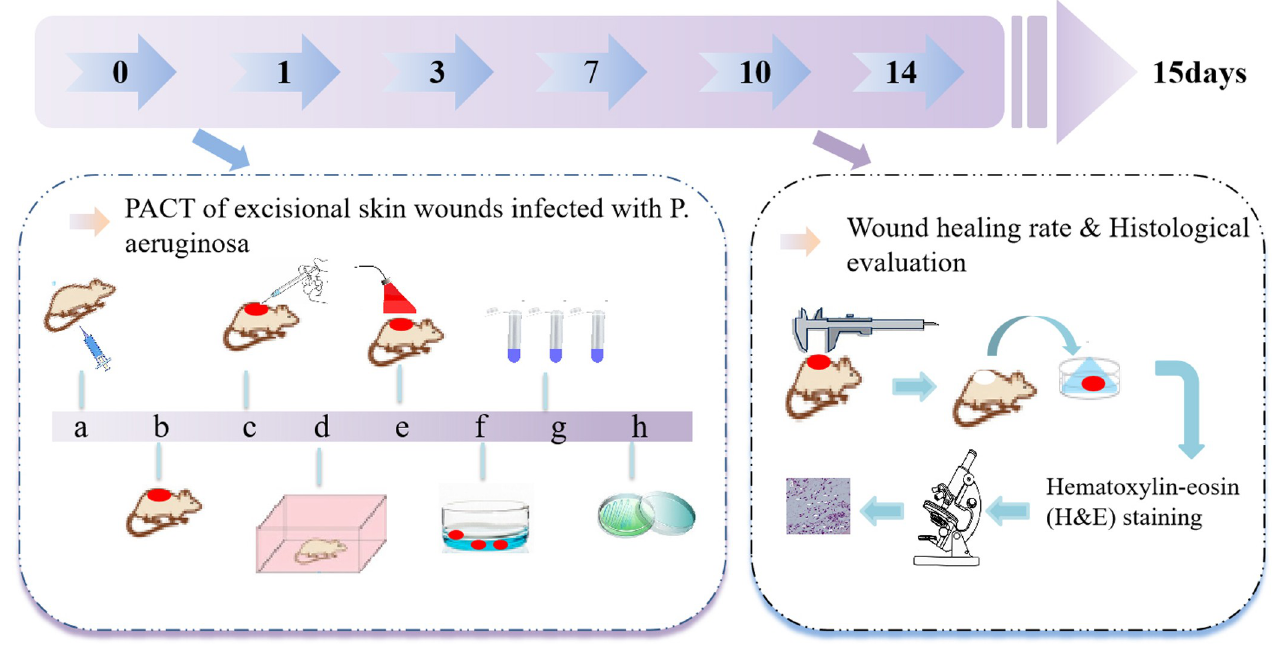
Fig 1. Model of wound infection treated with photodynamic antimicrobial chemotherapy and the detection procedure.